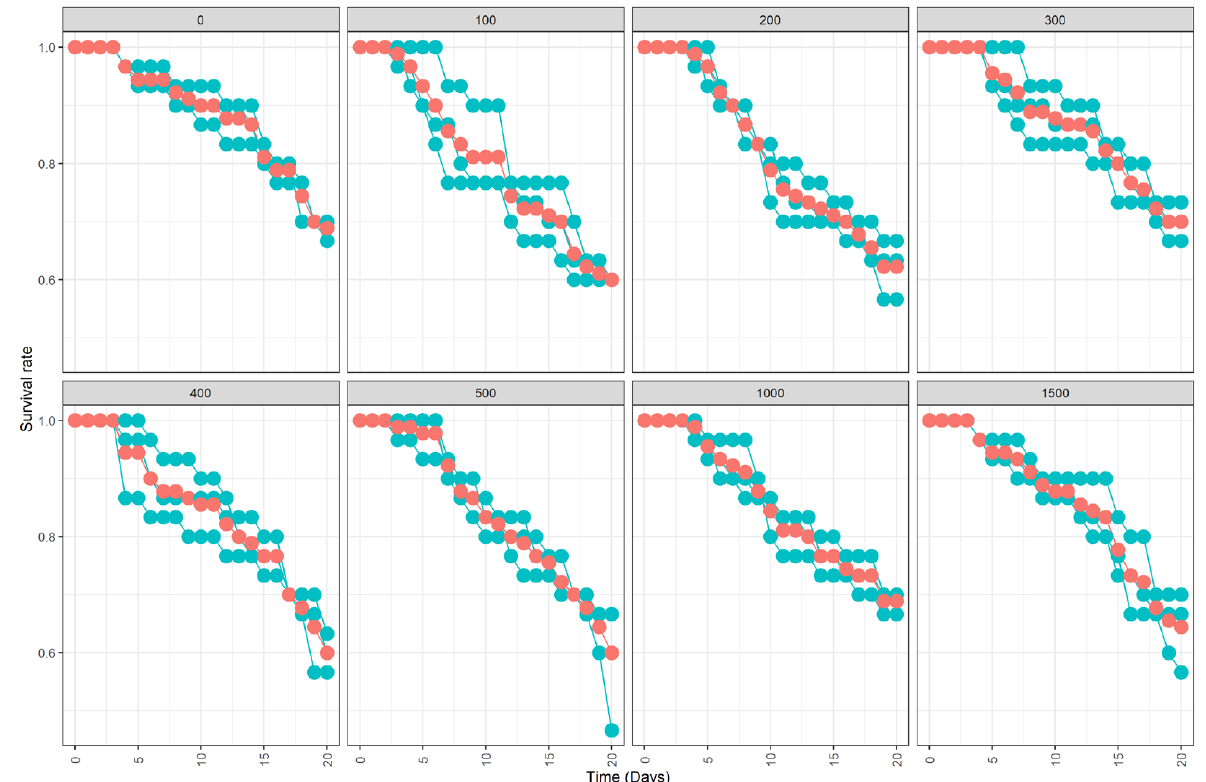
Figure 2. Mean (±standard error, SE) % survival of adult male Aedes aegypti 20 days following exposure to green florescent powder at 0, 100, 200, 300, 400, 500, 1000, and 1500 mg. Mean values are represented by red circles and outlined. Each series of dark olive-green dots represents an individual replicate (30 adult males).